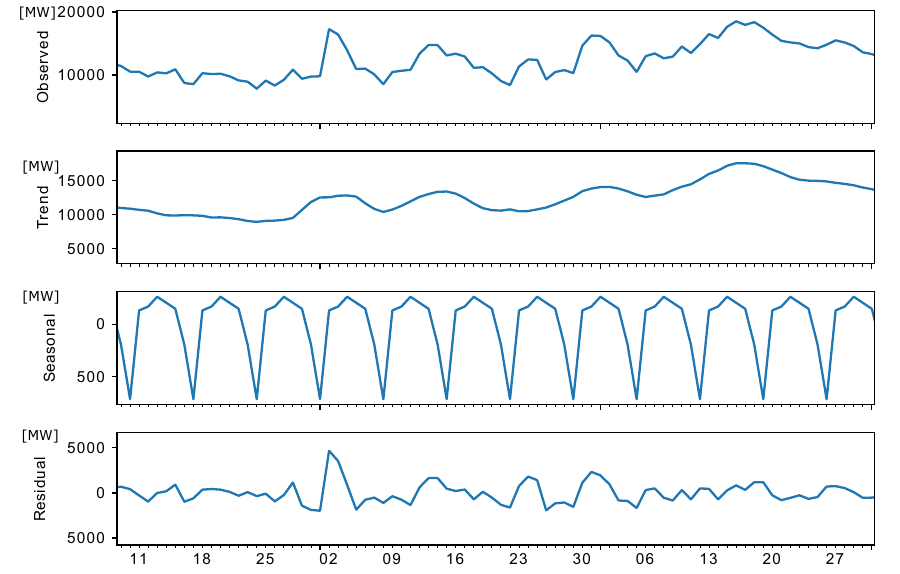
Figure 7. Production decomposition: observed, trend, seasonal, and residual power. X-axis indicates the day of the month from 9 May to 31